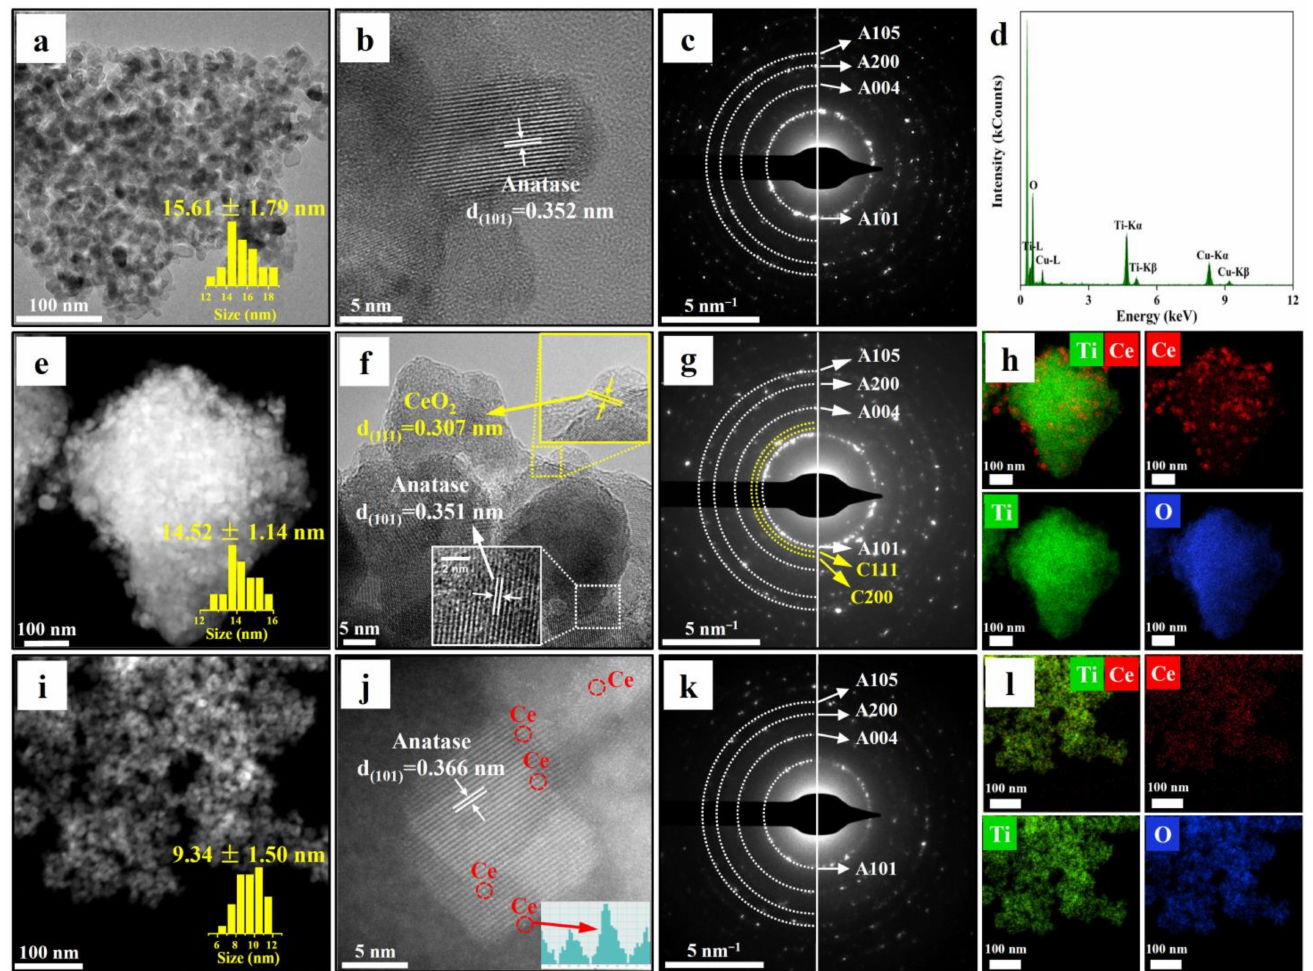
Figure 2. TEM images, HRTEM images, SAED patterns, and elemental mapping of ( a – d ) pure TiO 2 ; ( e – h ) CeO 2 -TiO 2 ; ( i – l ) Ce/TiO 2 ,